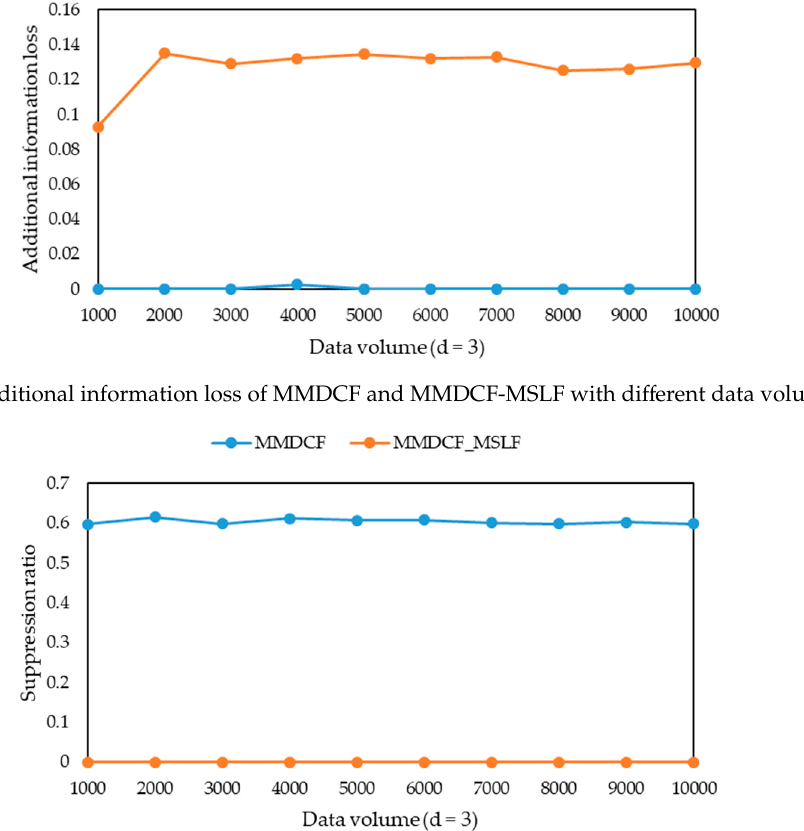
Figure 15. The suppression ratio of MMDCF and MMDCF-MSLF with different data volumes ( d = 3).